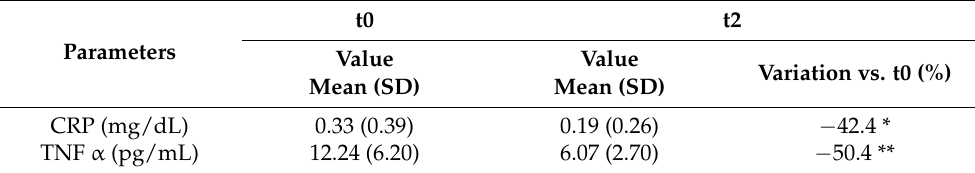
Table 5. Descriptive statistics for the inflammatory response measured at baseline (t0) and after 60 days (t2) of BBR-PP supplementation.